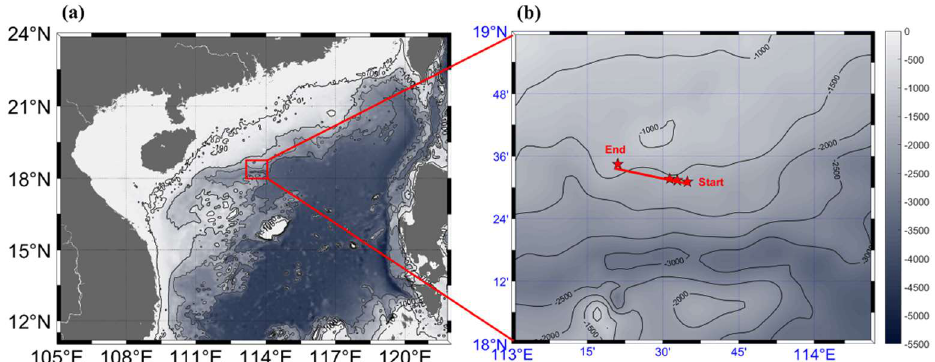
Figure 6. ( a ) Topography of the northern South China Sea and the measurement location (red rectangle). ( b ) Enlarged view of the area inside the red rectangle indicated in panel ( a ), showing the AUV start/end points and path, as well as the local bathymetry. In both panels, color indicates water depth (m).